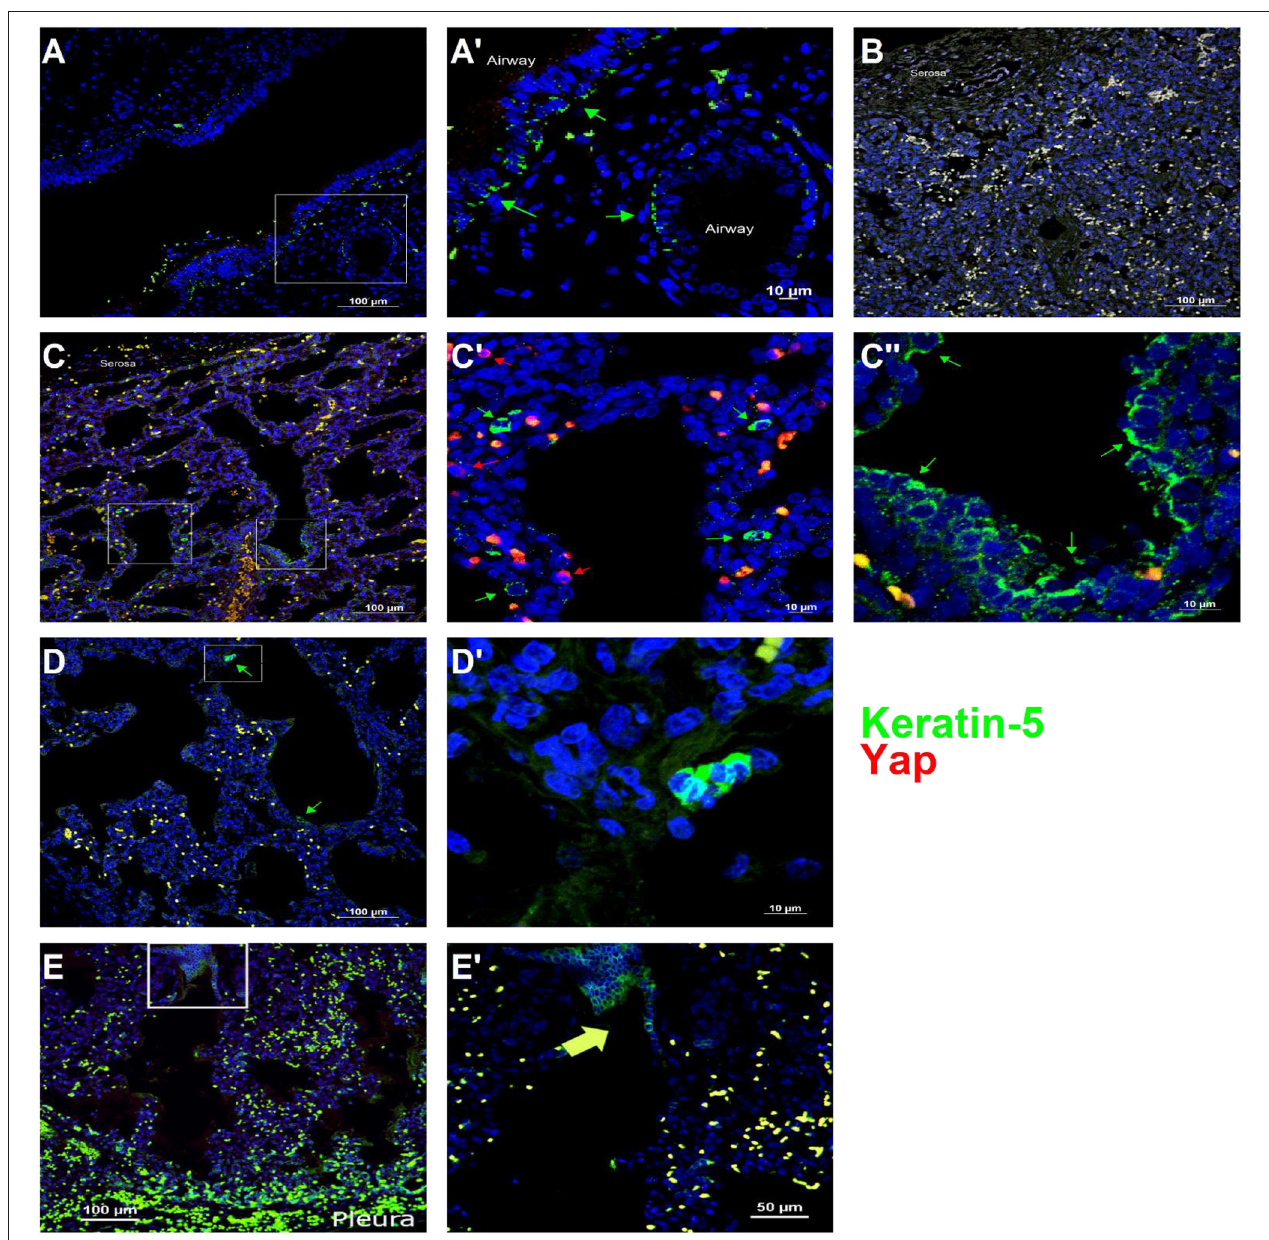
FIGURE 5 | Basal cells are present in the distal lung of infants with congenital high airway obstruction (CHAOS). (A) Staining was performed on lung specimens from infants of gestational age 34–36 weeks who died within 48h of birth with CHAOS, being a human analog to mouse tracheal occlusion. The lungs of both CHAOS and control infants had keratin-5-positive cells ( green arrows ) beneath the pseudostratified epithelium of the large conducting airways. (B) The subpleural lung of control specimens had no keratin-5-positive cells. (C) CHAOS lung had regions with clusters of keratin-5-positive cells. None of these cells were Yap-positive ( red arrows ), although cells containing both cytoplasmic and nuclear Yap were observed near keratin-5-positive cells. (D) Another CHAOS lung specimen showing clusters of keratin-5-positive cells just below the pleura. (E) Specimen of an infant with congenital diaphragmatic hernia treated with fetal endoscopic tracheal occlusion who died shortly after birth. In airways just below the pleura, clusters of keratin-5-positive basal cells can be identified. (A ′ ) , Magnified Image of A; (C ′ ) , Magnified Image of C-box 1; (C ′′ ) , Magnified Image of C-box 2; (D ′ ) , Magnified Image of D; (E ′ ) , Magnified Image of